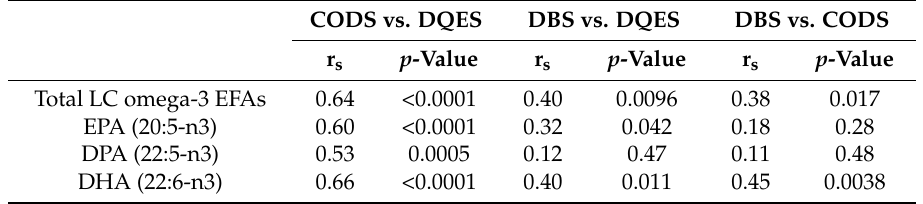
Table 3. Relationships between the long-chain omega-3 EFA quantification methods, calculated using the Spearman’s correlation coefficient (r s